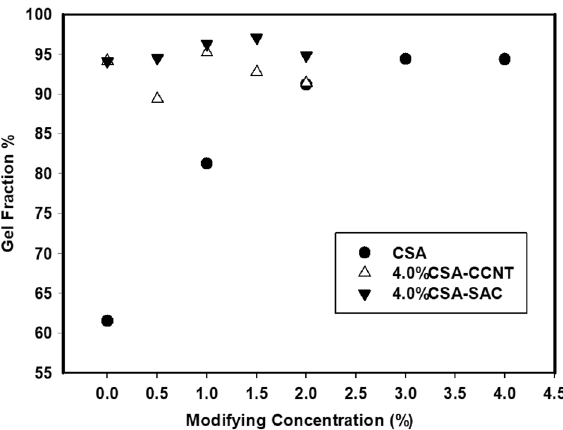
Figure 5. Gel fraction of CMC/PVA/AA and modified CMC/PVA/AA hybrid polyelectrolytic membranes with different amounts of CSA, CCNT and SAC.